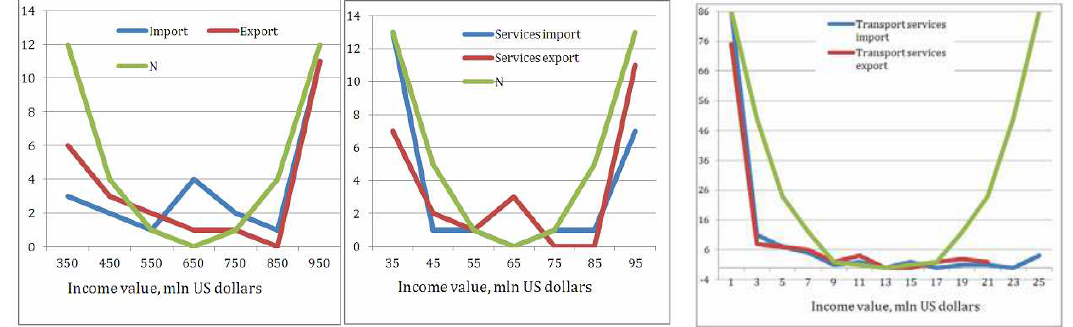
Fig. 2. Indicators of the level of economic processes asymmetry in